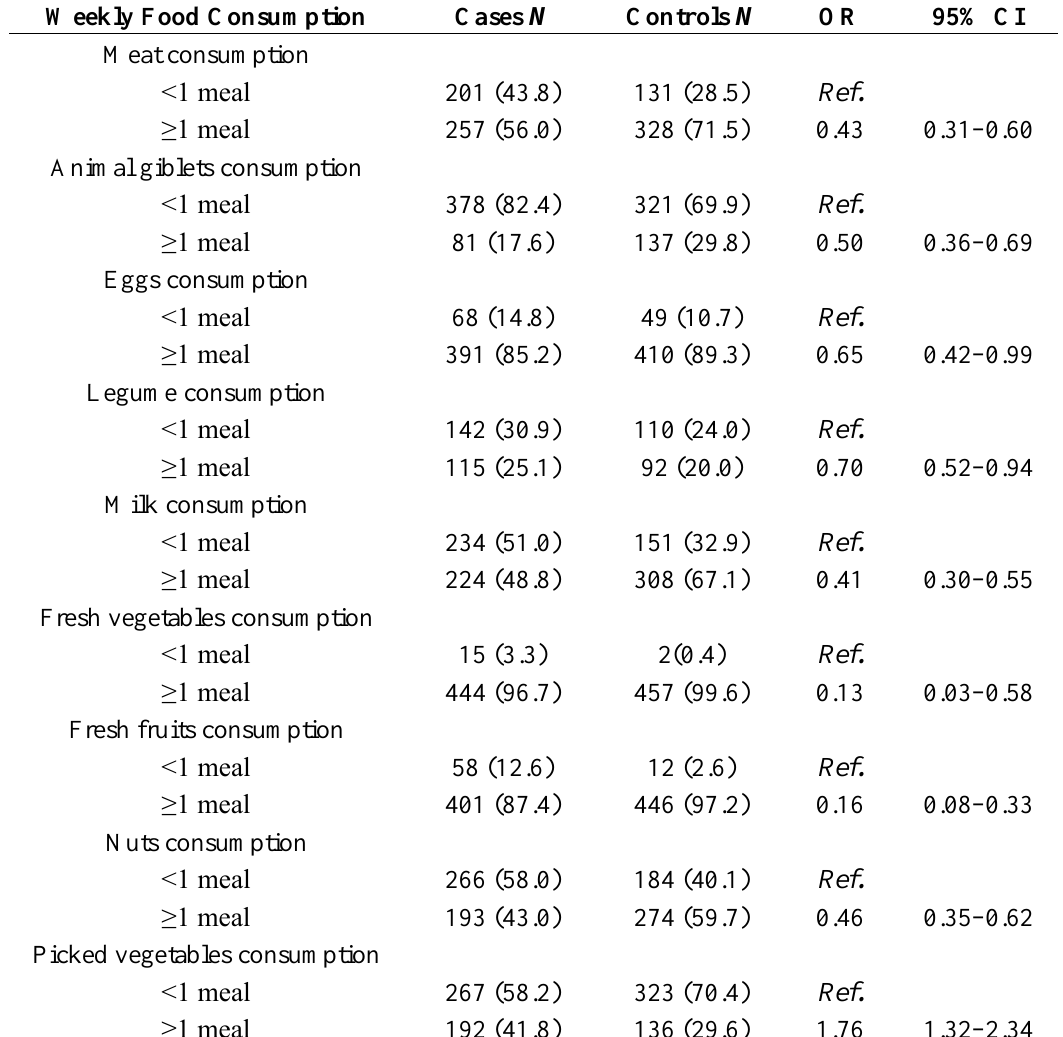
Table 2. Univariate analysis of the association between weekly food consumption and NTDs risk.